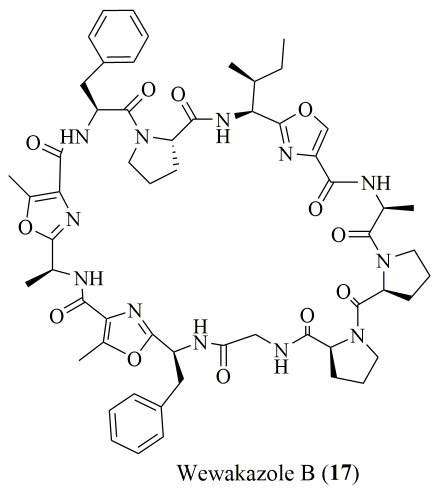
Figure 3. Structure of wewakazole B ( 17 ) isolated from a marine cyanobacteria.